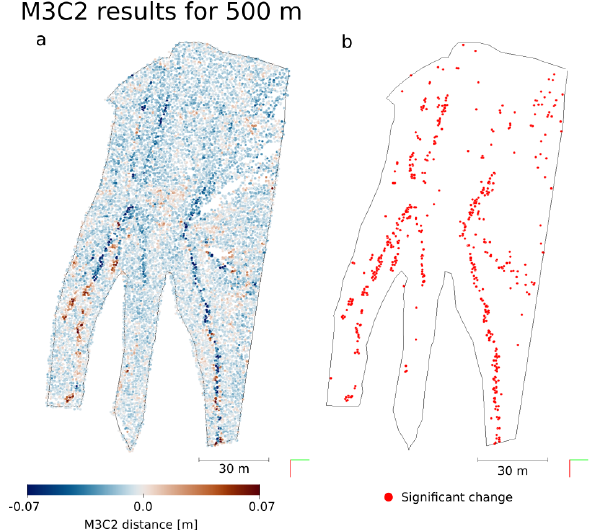
Figure 5. M3C2 point cloud result for 500 m flight altitude after 5 days. a) M3C2 point cloud distances, b) significant change.